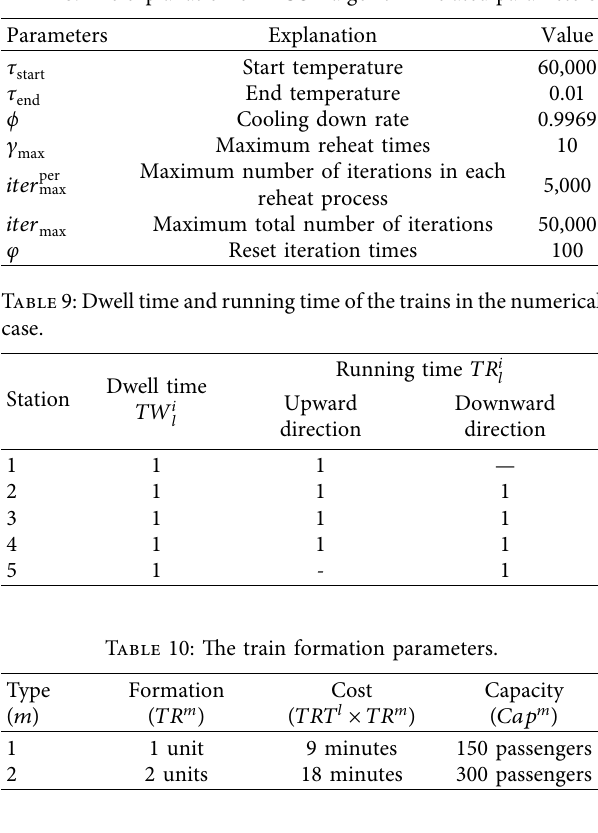
Table 8: The explanation of MOSA algorithm-related